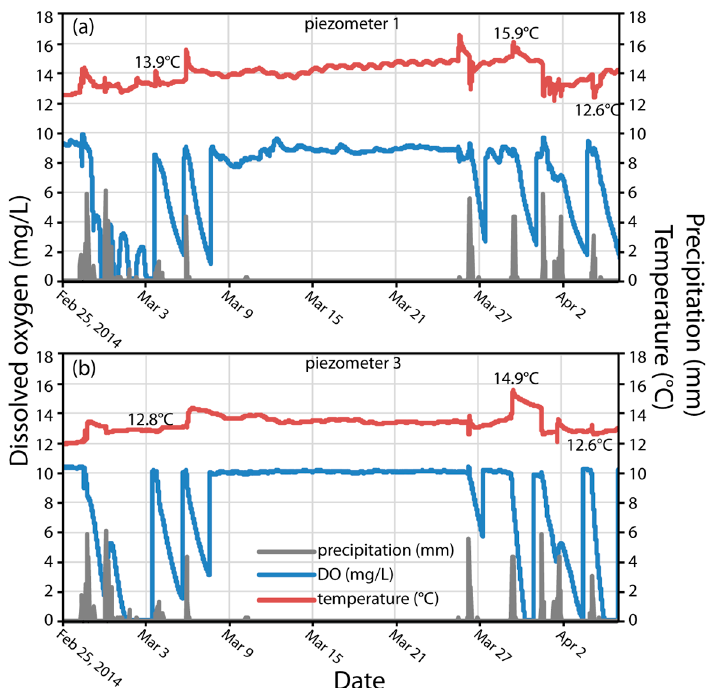
Figure 7. Hourly time series of precipitation (mm) (gray line), dissolved oxygen (DO) concentration (mg ∙ L ‒ 1 ) (blue line), and water temperature (°C) (red line) for: ( a ) piezometer 1; and ( b ) piezometer 3 for 25 February to 2 April 2014. The numbers above and below the temperature time series are the water temperatures for that particular storm event.